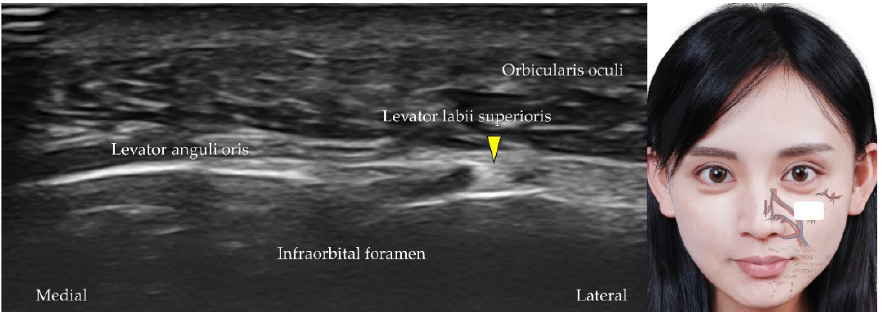
Figure 13. Ultrasound imaging of the infraorbital nerve ( yellow arrowhead ). White square , footprint of the ultrasound transducer.